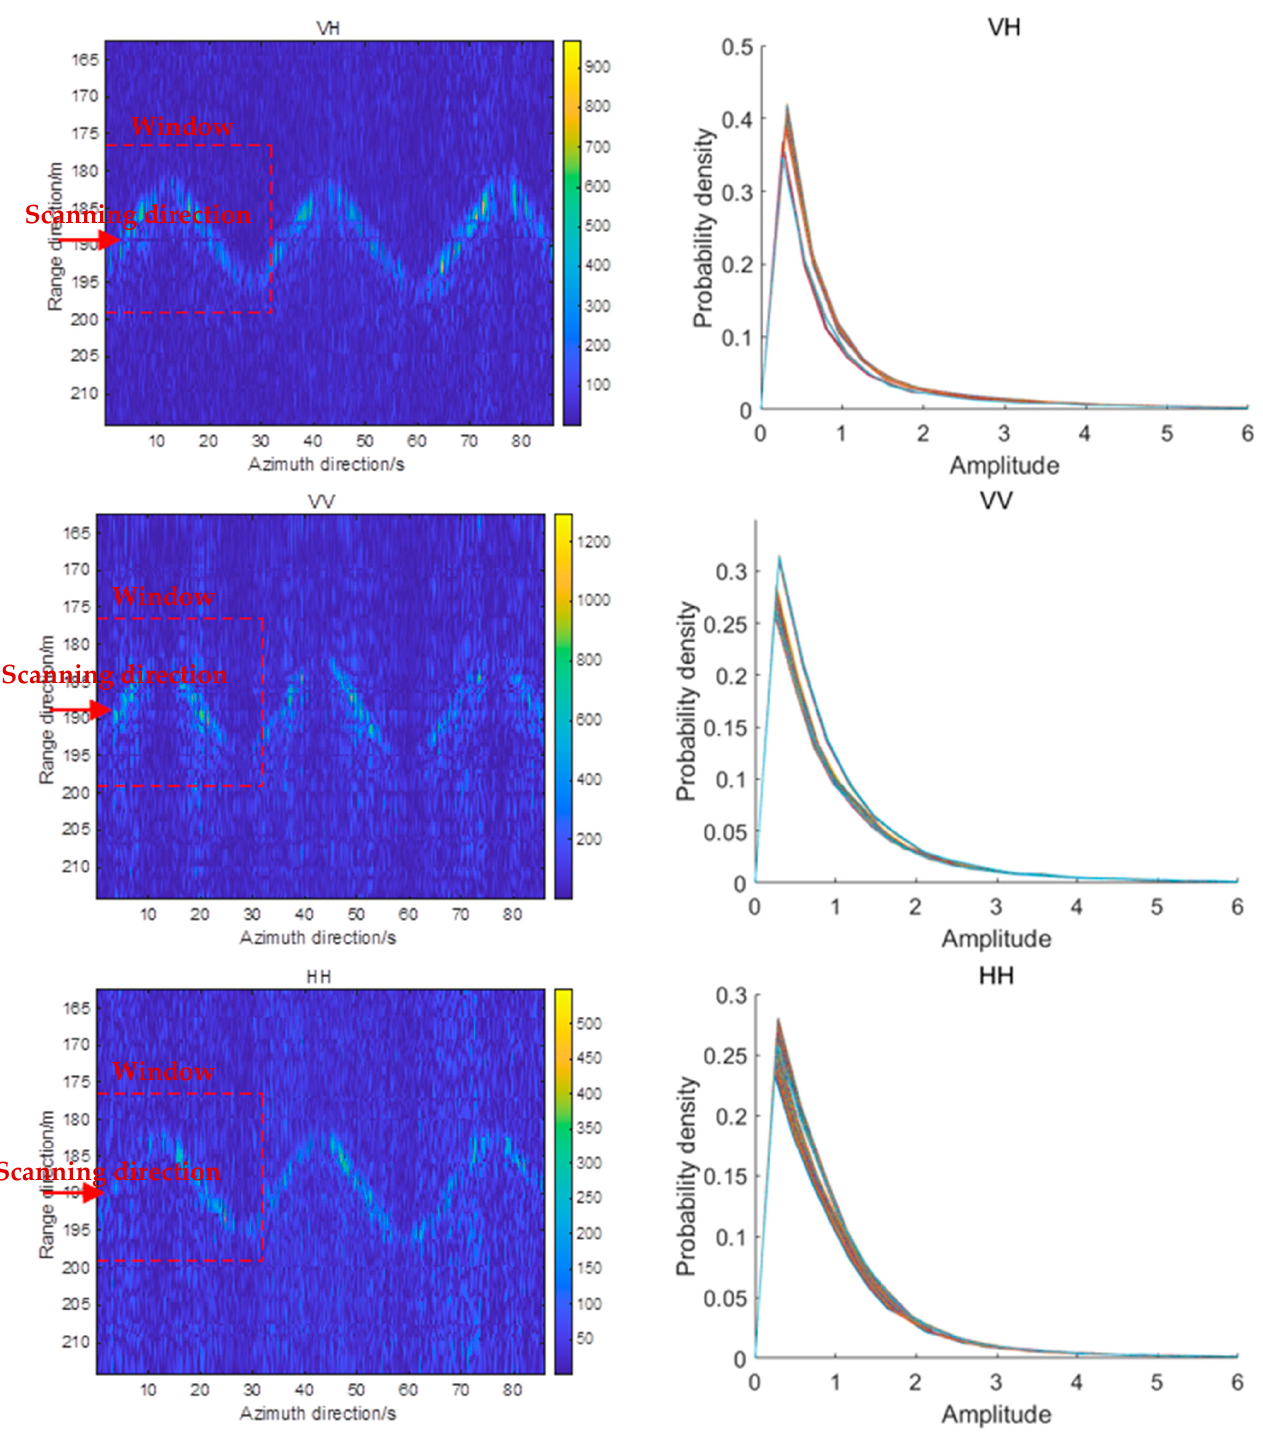
Figure 13. The probability density curves for the non-motor vehicle.